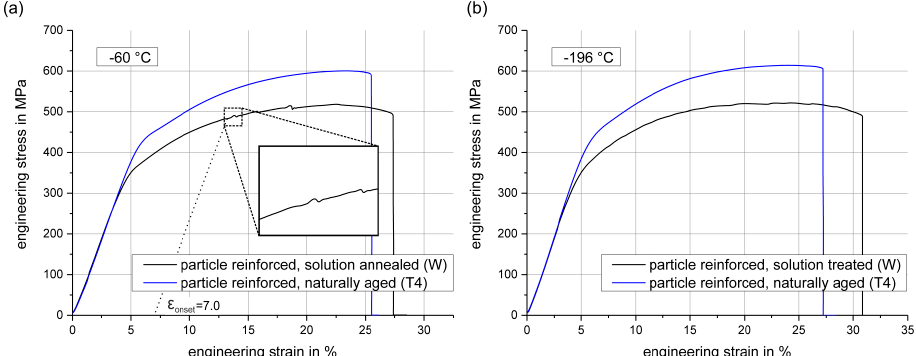
Figure 7. Tensile engineering stress-strain curves at low temperatures. ( a ) Particle reinforced AA2017 material in the solution annealed (W) and naturally aged (T4) conditions at − 60 ◦ C. ( b ) Particle reinforced AA2017 material in solution annealed (W) and naturally aged (T4) conditions at − 196 ◦ C. Only the W-conditions exhibit some serrated flow (inset at higher magnification). PLC effects are reduced by decreasing the testing